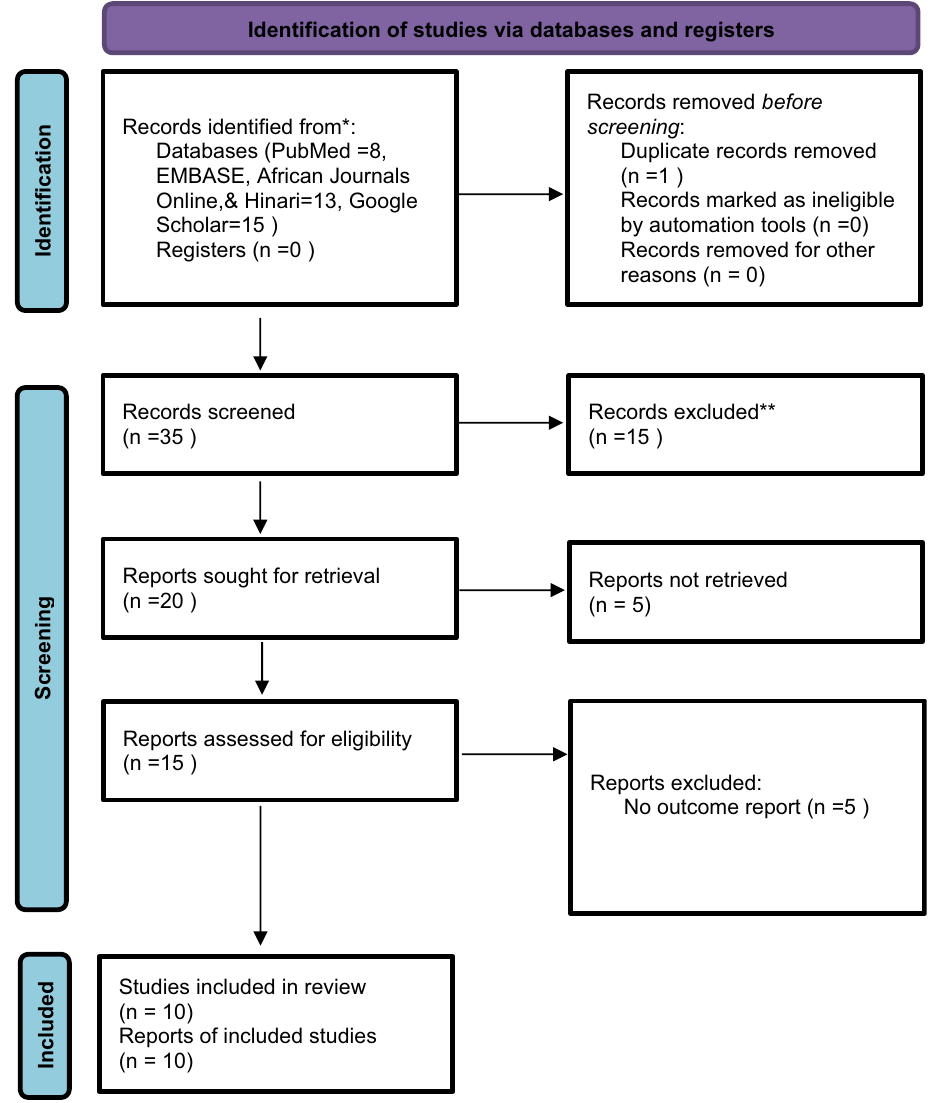
Figure 1. PRISMA flow diagram for showing screening and selection process of duties.